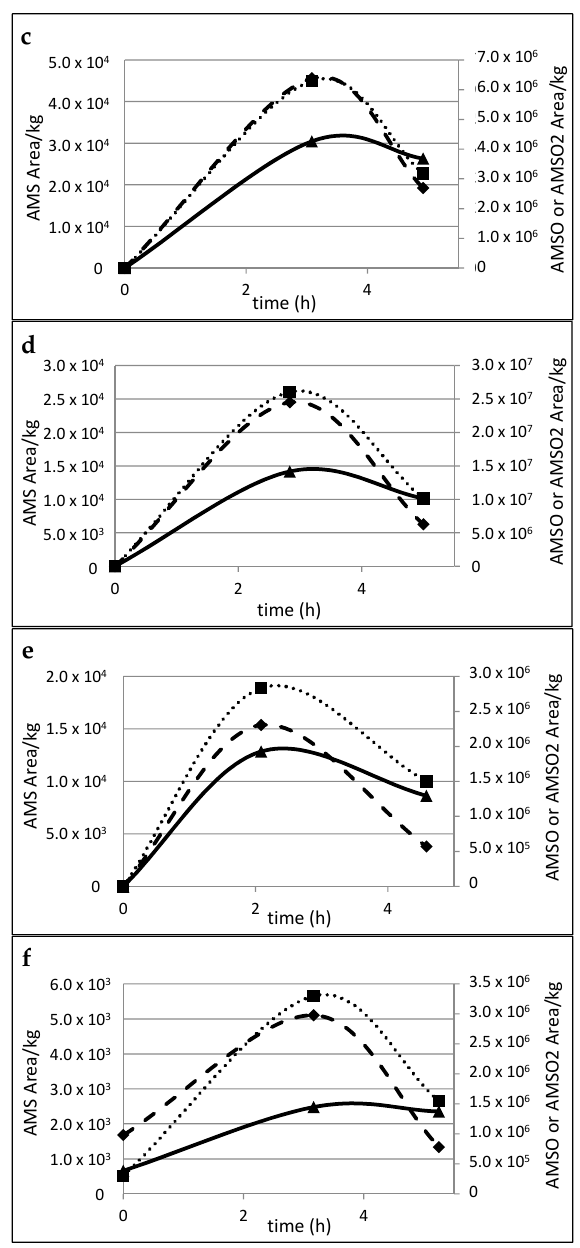
Figure 4. Time-resolved metabolite profiles of AMS, AMSO and AMSO 2 , a – f : Milk samples taken from six different mothers. AMS ( ♦ ), AMSO ( ■ ), AMSO 2 ( ▲ ), time 0 h represents the milk sample collected prior to garlic consumption, following times represent milk samples after garlic consumption. Garlic was consumed 5 to 15 min after the first milk sample was given.